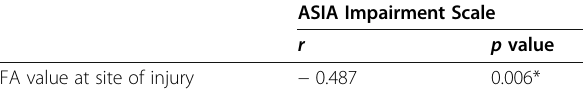
Table 7 Spearman ’ s correlation between FA at the level of injury and ASIA impairment